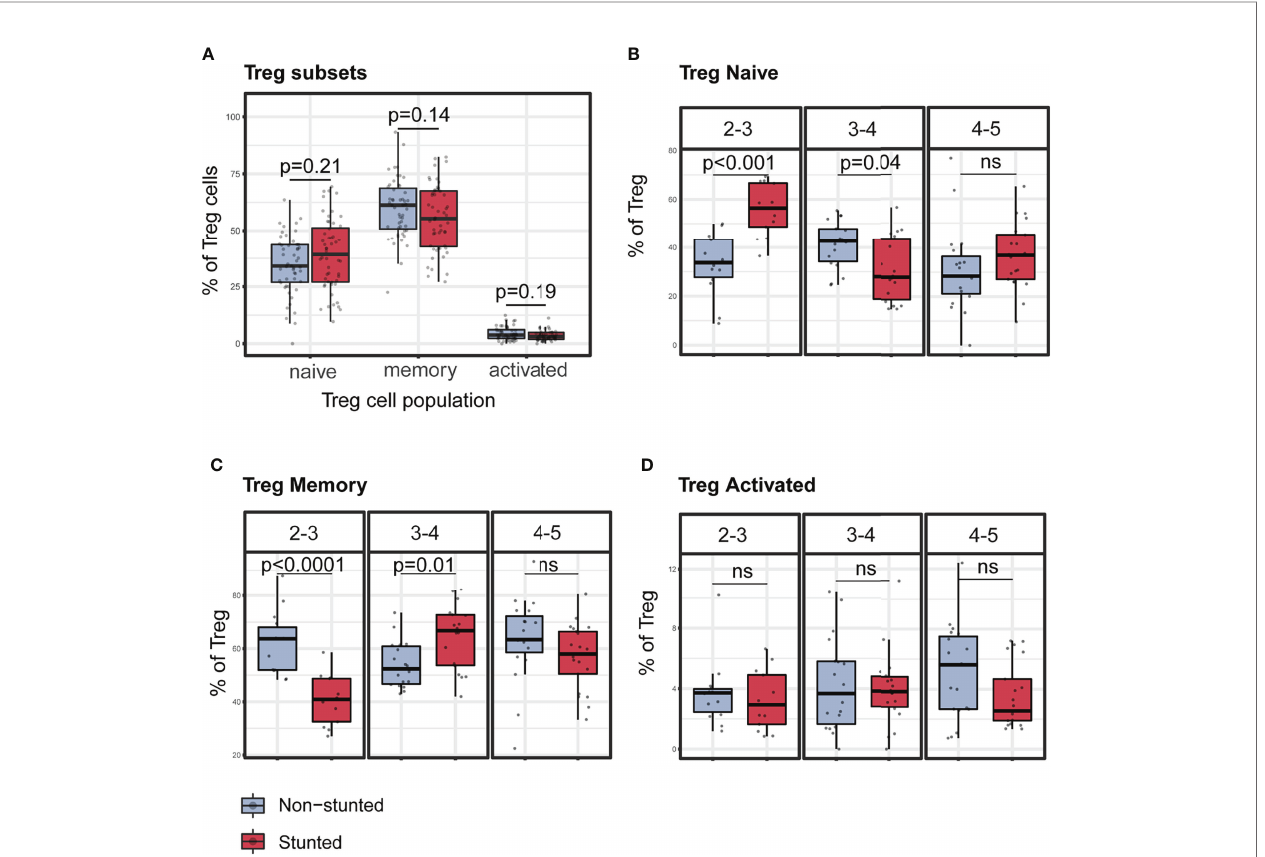
FIGURE 4 | Representative graphs of the percentages of Treg cells subsets strati fi ed by nutritional status and age sub-groups. (A) Percentages of regulatory T cell subsets children by stunting status. Percentages of naïve (B) , memory (C) , and activated (D) Treg cells by stunting status and age sub-groups (years). P-values were FDR corrected after Mann-Whitney test. N total= 103, N non-stunted = 51, N stunted= 52. ns, not signi fi